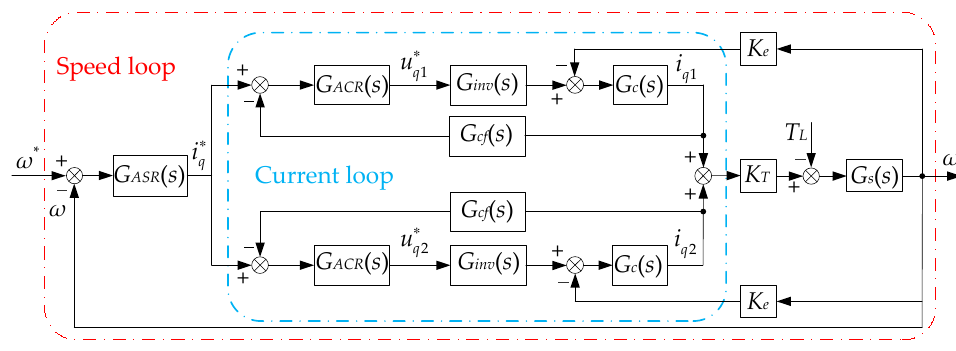
Figure 5. Transfer function of DRPMSM control system.